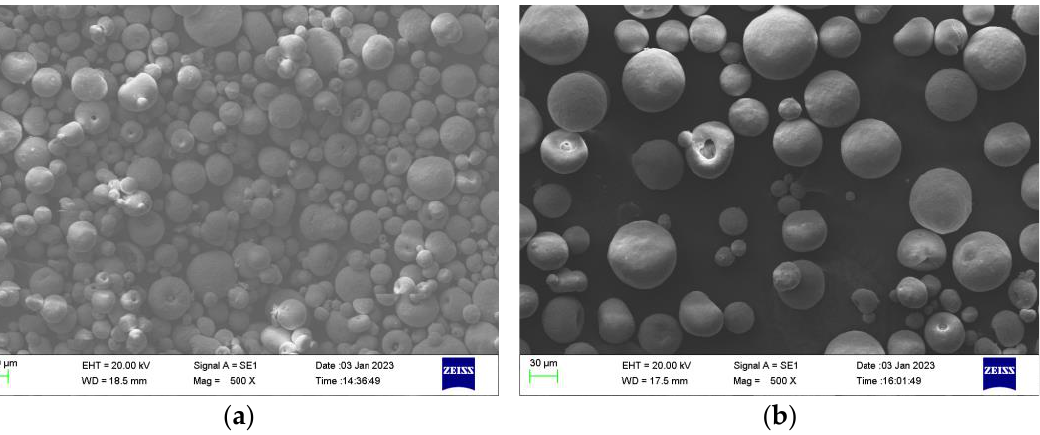
Figure 2. SEM images showing morphologies of the 8YSZ powders: ( a ) 15 – 45 µm; ( b ) 45 – 90 µm.